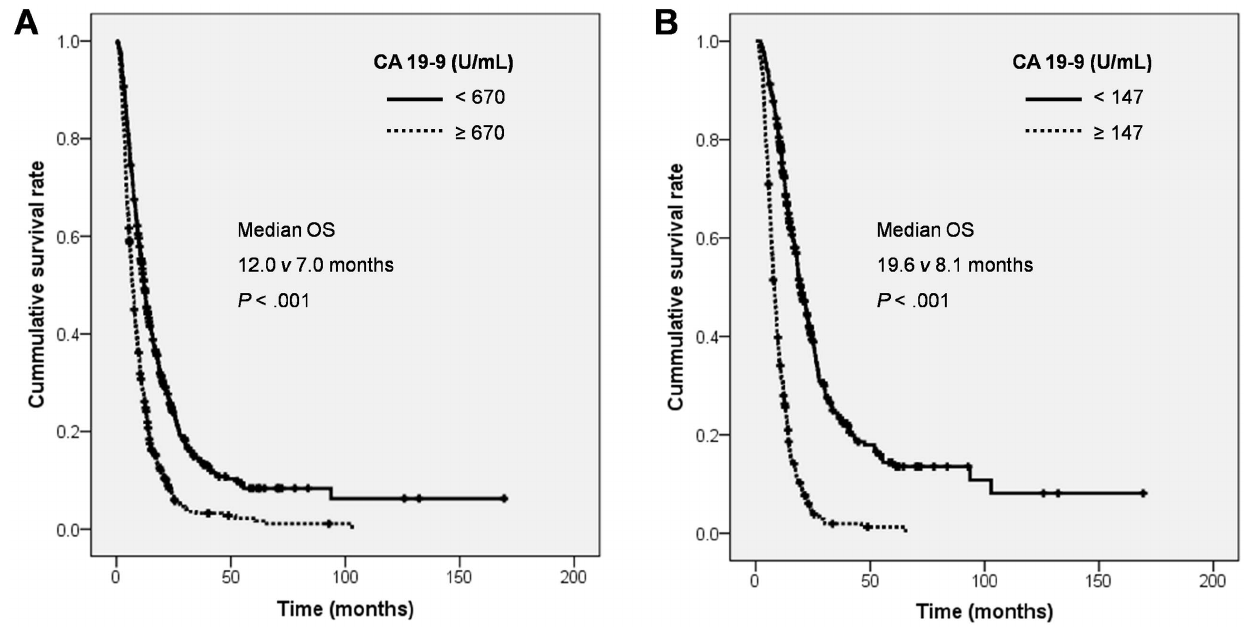
Figure 1. Kaplan-Meier curve of OS according to CA 19-9 level in various clinical courses. (A) Initial CA 19-9 with median cut off value and (B) post-treatment CA 19-9 with median cut off value. Abbreviations: OS, overall survival.